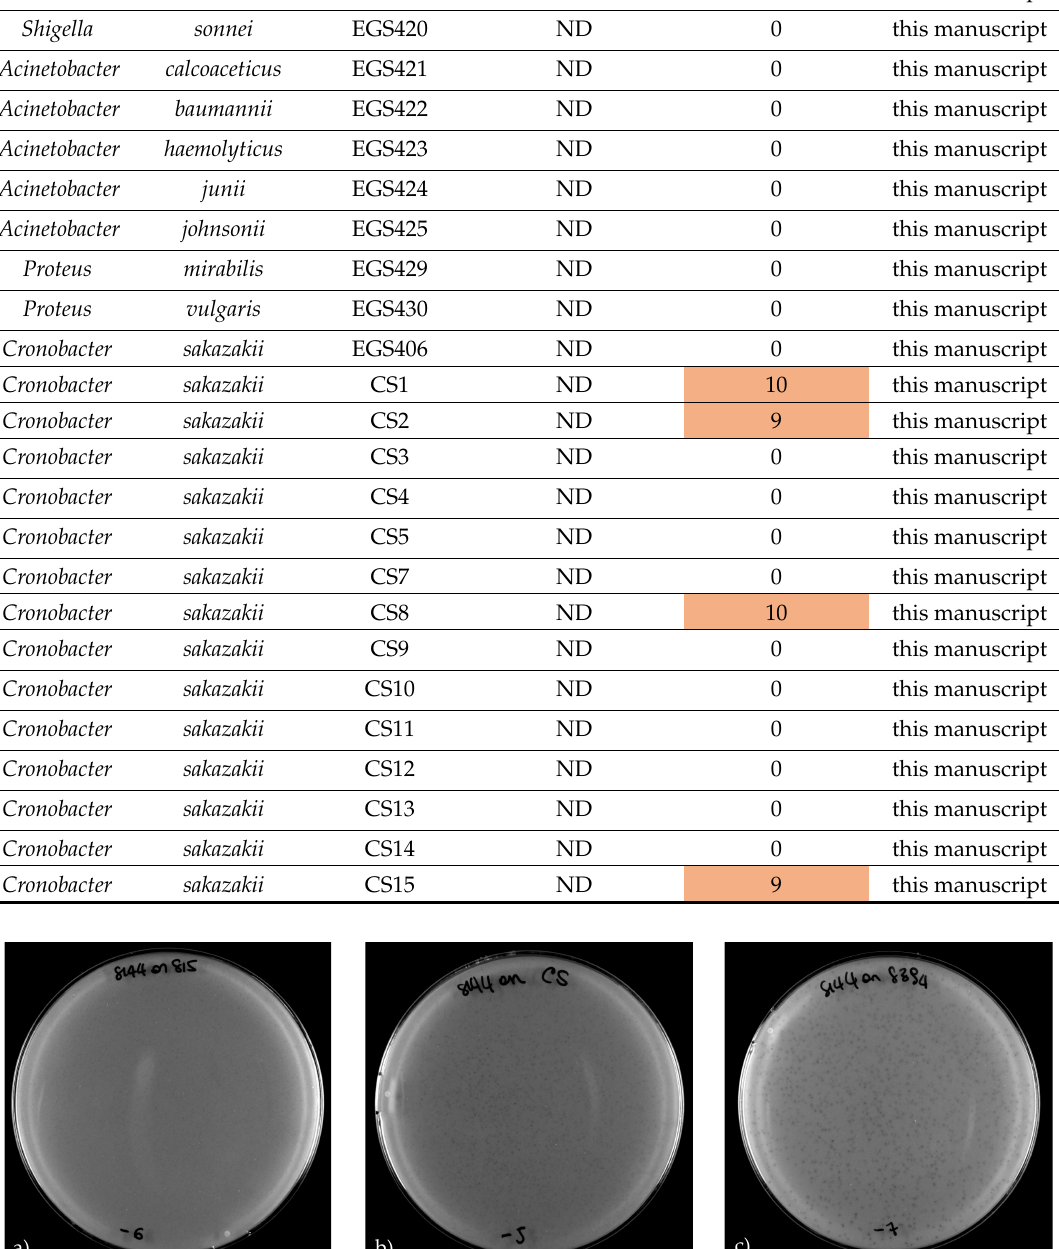
Figure A1. S144 plaque morphology on ( a ) S. Infantis S15, ( b ) C. sakazakii CS1 and ( c ) S. Muenster Figure 1. S144 plaque morphology on a ) S. Infantis S15, b ) C. sakazakii CS1 and c ) S. Muenster S394.